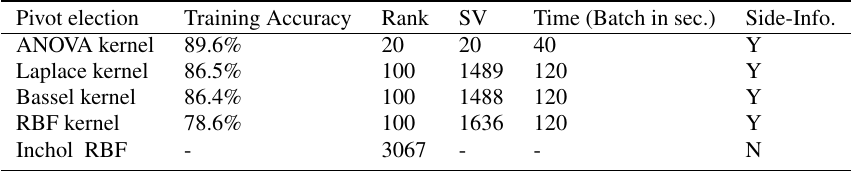
TABLE IV Reconstruction Error: Results for the UCI-Landsat dataset when pre-processing features with statistical properties of kernels (included Incomplete-Cholesky).Configuration:Intel i5-2435M Processor, 2.40GHz; 4GB DDR3. The timings included show feature extraction during pre-processing. Side-Info column indicates if it is supervised or unsupervised learning.